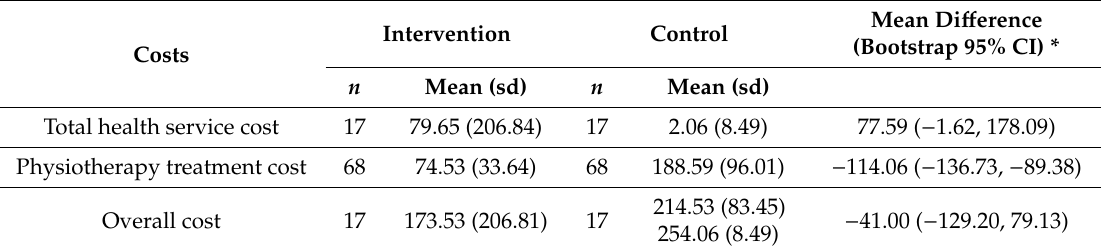
* Percentile confidence intervals based on 1000 bootstrap